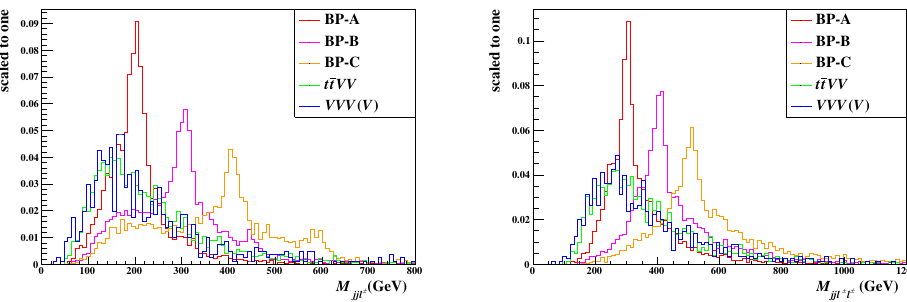
Table 5 . Same as table 4, but for the SST signature.